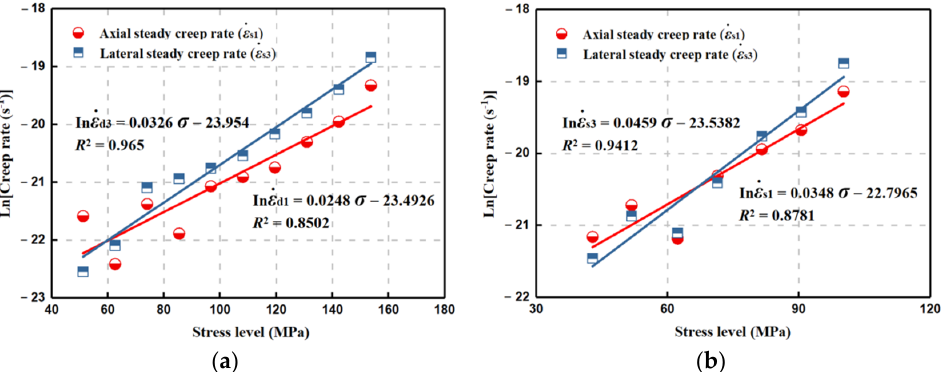
Figure 6. Relationship between steady creep rate and stress level for dry and saturated quartz sandstone specimens. ( a ) Dry specimen. ( b ) Saturated specimen.